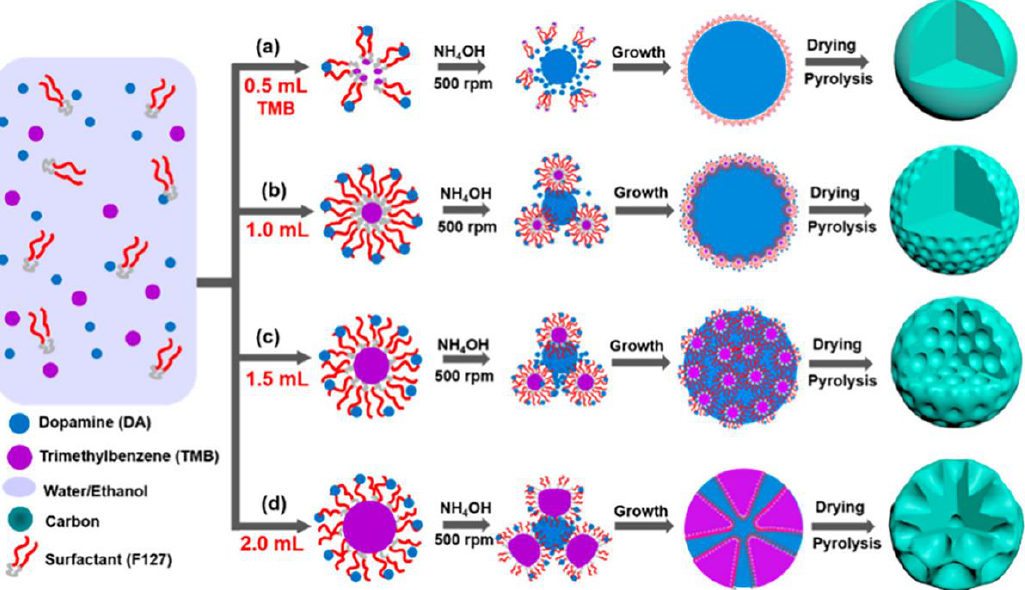
Figure 3. The schematic illustration of the formation process using the versatile nanoemulsion assembly approach to produce the N-doped mesoporous carbon nanospheres with various morphologies and mesostructures. Reproduced with permission from ref. [19]. Copyright © 2019, American Chemical Society.